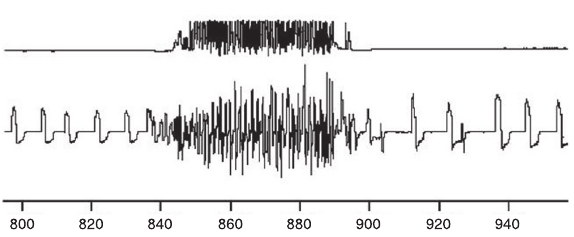
Figure 3. Ventilatory airflow rates in Varanus exanthematicus running on a treadmill. The upper trace is a recording of lateral bending of the trunk whilst running for 30 s; the lower trace is a pneumotachograph recording of ventilatory airflow at the nares, with expiration recorded as deviations above the baseline. The active lizard shows a marked disruption of normal airflow (Modi - fied from Ref. 58, with permision).